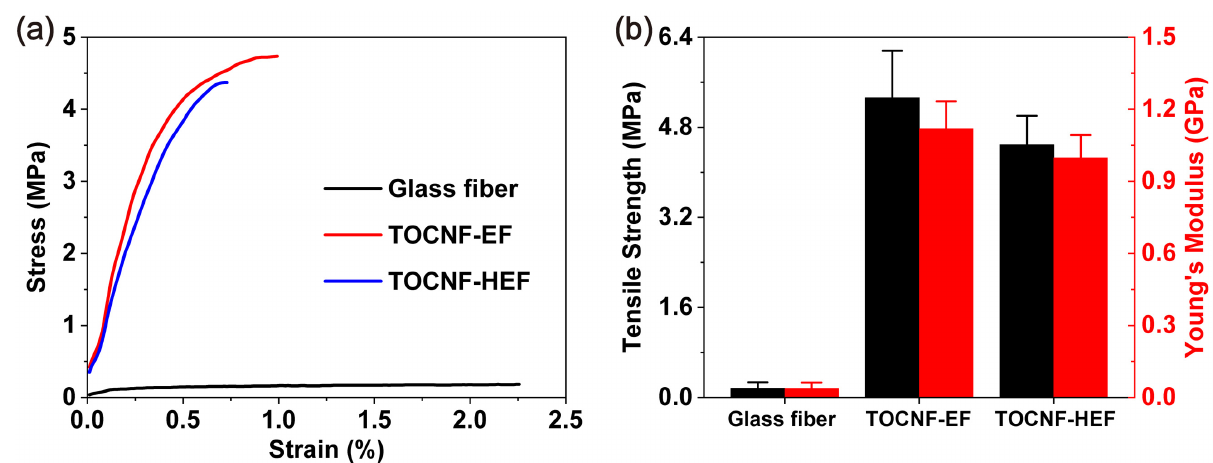
Figure 8. ( a ) Typical stress − strain curves of glass fiber and TOCNF separators; ( b ) tensile strength and Young’s modulus of the materials in ( a ). The above tests were conducted at room temperature.